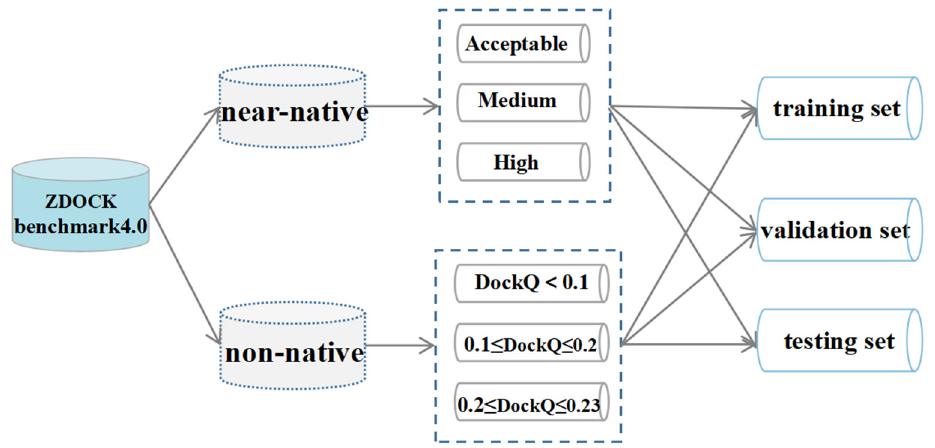
Figure 1. The procedure of dataset splitting. In ZDOCK benchmark 4.0, we defined Acceptable, Medium and High decoys as near-native decoys and Incorrect decoys as non-native decoys. Since near-native and non-native decoys were extremely unbalanced, we chose the non-native decoys according to the value of DockQ as follows: one-third of non-native decoys were selected from those with a DockQ less than 0.1, another third came from those with a DockQ between 0.1 and 0.2, and the rest came from those with a DockQ between 0.2 and 0.23. Then, all the protein complexes were partitioned into 5 equal parts. The ratio of the training, validation and testing sets was 7:1:2. Table 1. The number of training, validation and testing set in different folds. Training Set Validation Set Testing